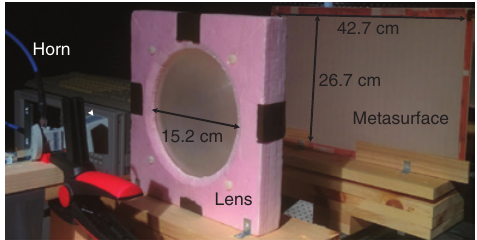
Figure 10: Quasi-optical setup utilizing a Rexolite lens to focus the Gaussian beam pattern of a horn antenna on to the metasurface under test to achieve planar wave illumination, which is used for characterization of the metasurface specular reflections. Obtained from Ref. [60].